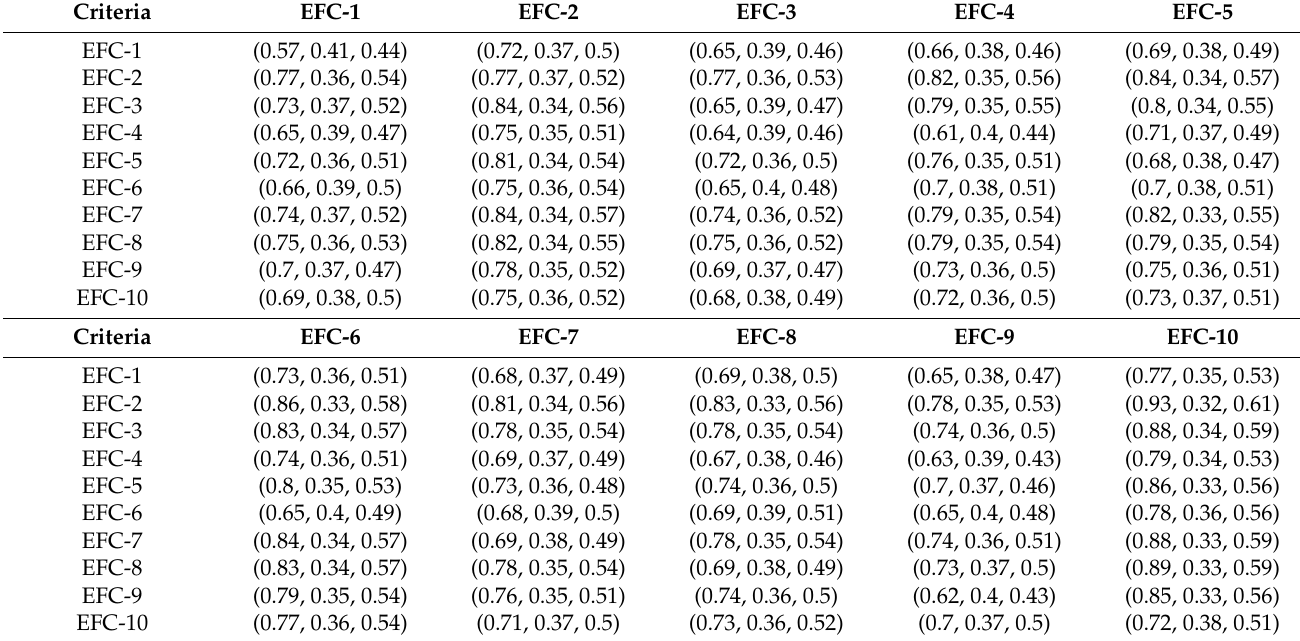
Table A5. The SF total-influence matrix.